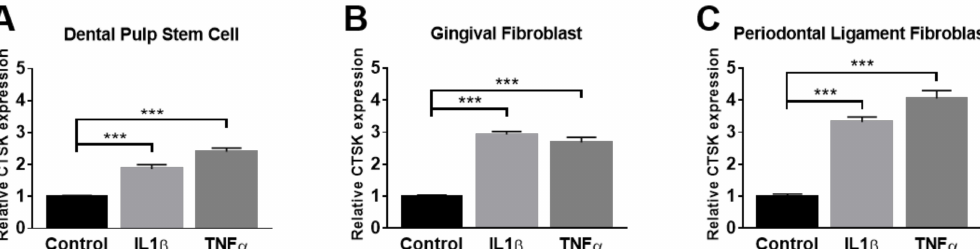
Figure 2. The expression of CTSK in response to inflammatory cytokine in osteoclastogenesis-supporting cells. Three types of osteoclastogenesis-supporting cells, including dental pulp stem cells ( A ), gingival fibroblasts ( B ), and periodontal ligament fibroblasts ( C ), were treated with 10 ng/mL of TNF α or IL-1 β for 24 h. The mRNA expression of CTSK was determined by qPCR and normalized to the expression levels of β -actin. Data represent the mean ± S.E.M. *** p < 0.001 by one-way